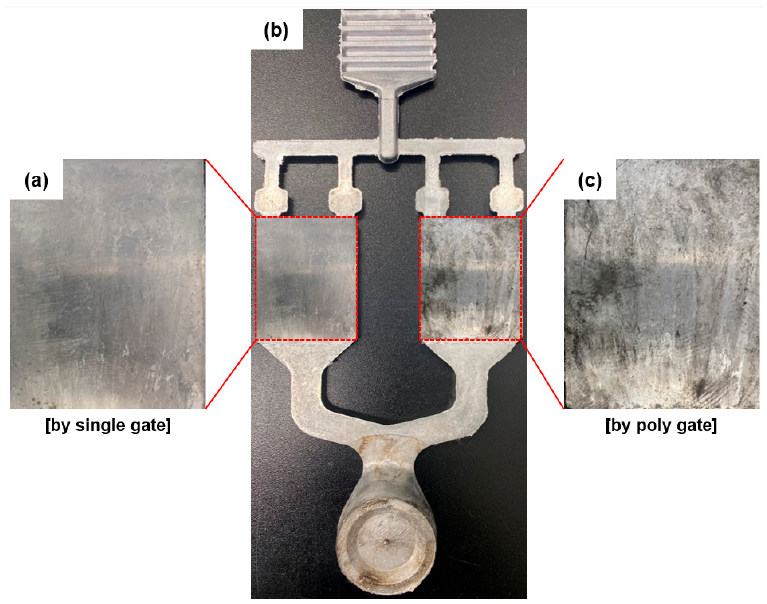
Figure 4. Images of ( b ) as-cast state and ( a , c ) cast product of A383 alloy and CNT-added composites cast using a single gate and poly gate using ORDC.